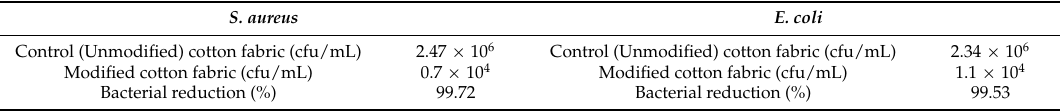
Table 3. Bacterial reductions of the IPN hydrogel (IPN-3)-modified cotton